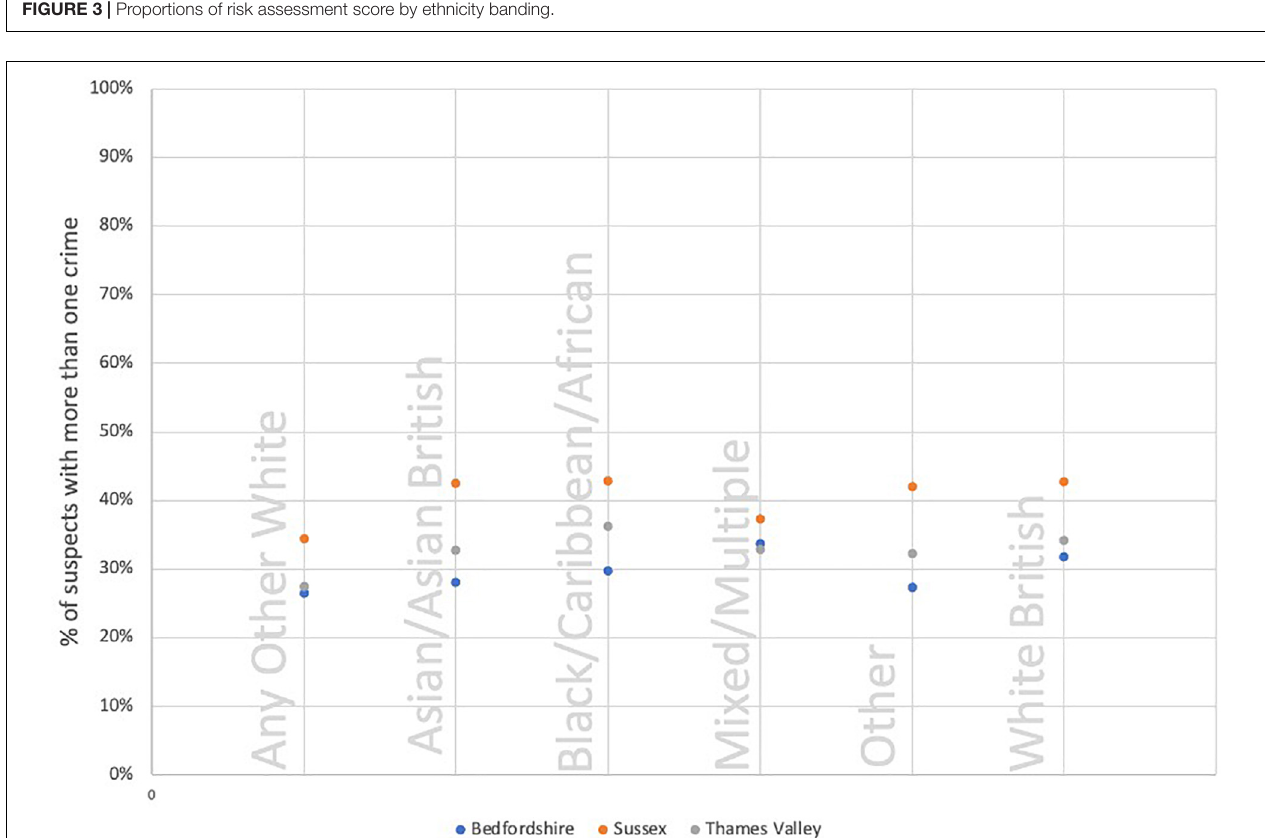
FIGURE 4 | Proportion of suspects within the power few, by ethnicity banding.